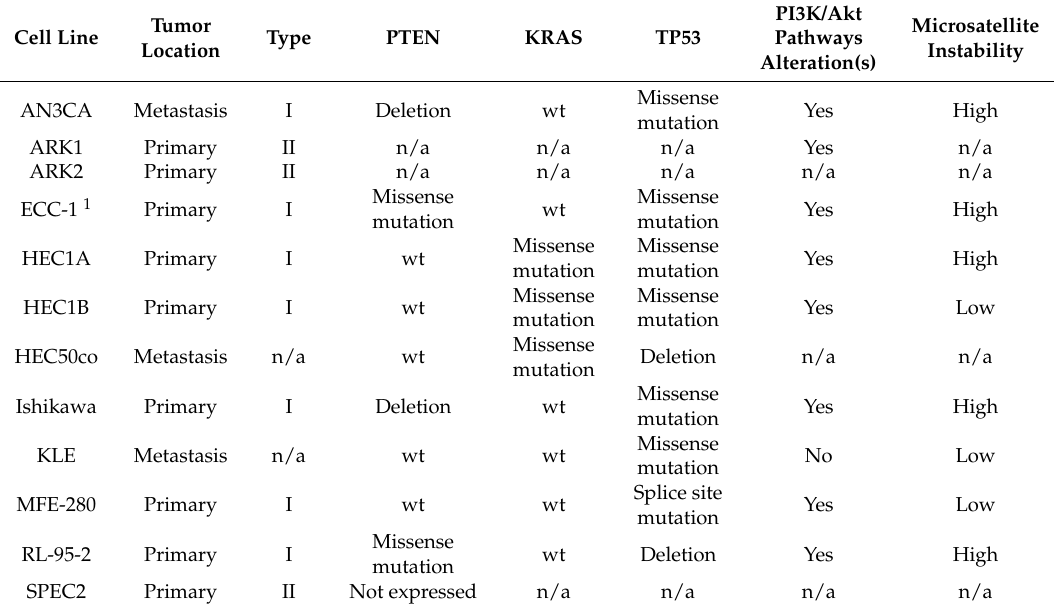
Table 1. Endometrial cancer (EC) cell line information. Genomic alterations of the most commonly used type I and type II EC cell